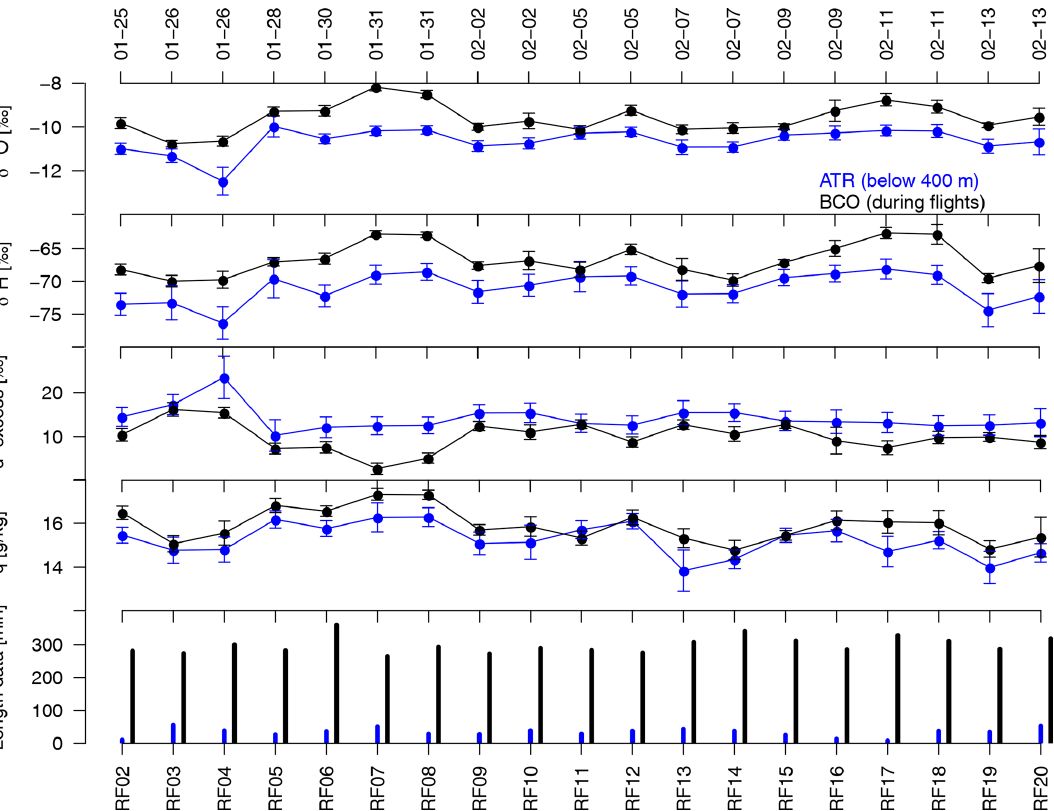
Figure 19. Comparison of the ATR isotope measurements below 400m (in blue) with the ground-based measurements from the Barbados Cloud Observatory (BCO) during each ATR flight (in black). The comparison is done (from top to bottom) for δ 18 O, δ 2 H, d excess (‰), specific humidity (gkg − 1 ) and the length of measurements (expressed in